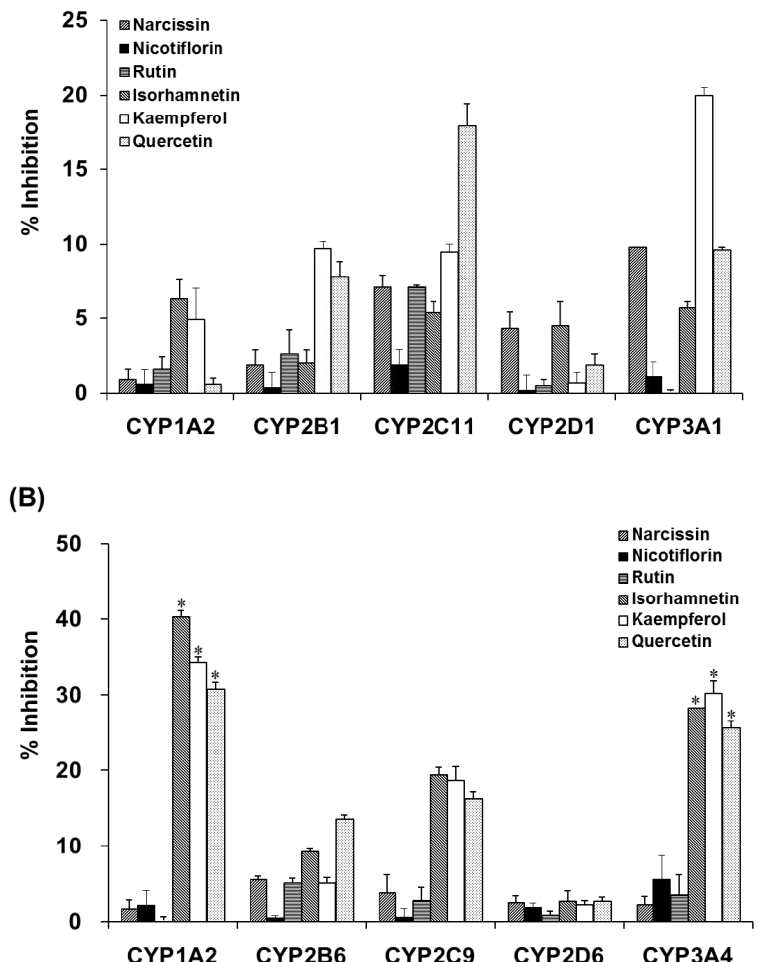
Figure 5. The inhibitory activity of cytochrome P450 (CYP) isozymes in liver microsomes from OVX rats ( A ) and pooled human liver microsomes ( B ) by six major flavonoid constituents present in Opuntia ficus indica fruit extract (OFIE). Percent inhibition was calculated when the enzyme activity was set as 100% in the incubation sample without any inhibitor. Differences among % inhibition of each phenotyping reaction in the various treatment groups versus that in the control group were determined with ANOVA followed by a Bonferroni-Dunn test. An asterisk indicates p < 0.001.